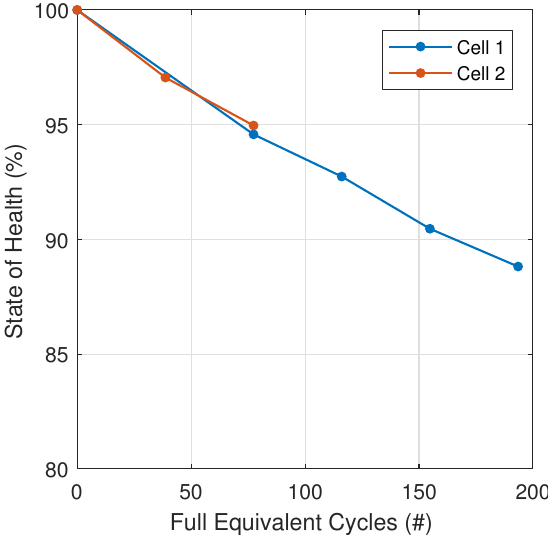
Figure 11. The influence of the standardized Worldwide harmonized Light vehicle Test Procedure (WLTP) driving cycles on the capacity retention of Si-alloy cells.